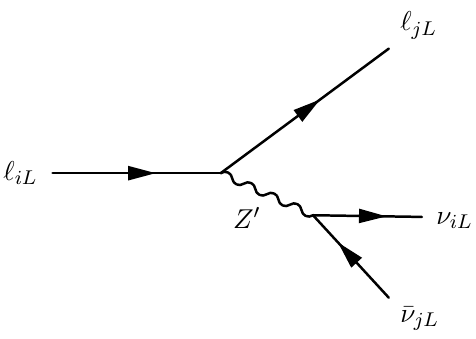
Figure 12 . Diagrams of the lepton decay ‘ i ! ‘ j (cid:23) i (cid:22) (cid:23) j . The same diagram also exists for right- handed charged leptons and for the lepton (cid:13)avor-violating decays ‘ i ! ‘ j (cid:23) j (cid:22) (cid:23) i , where the neutrino (cid:13)avors are